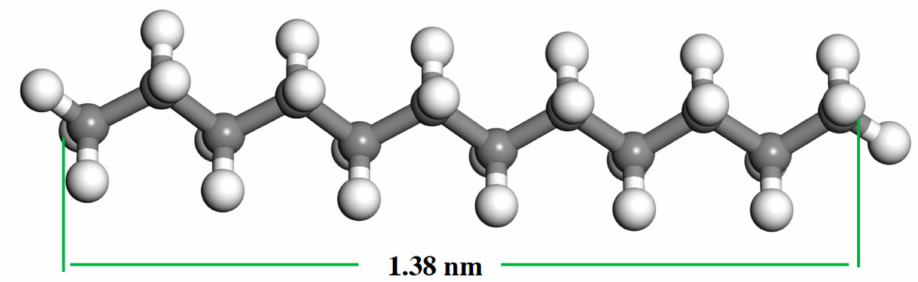
Figure 5. Molecular structure of dodecane. Colored balls represent C in gray, H in